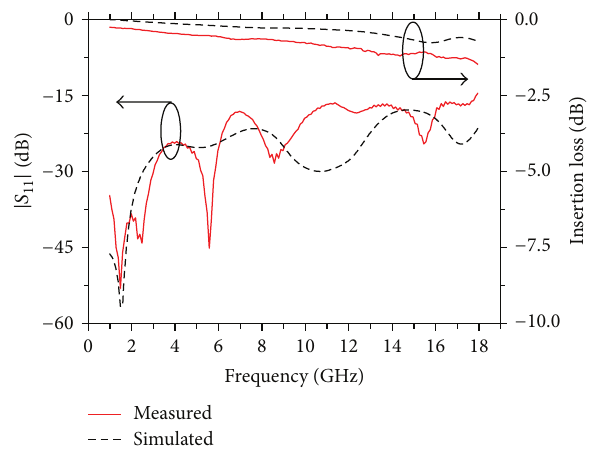
Figure 12: Reflection coefficient and insertion loss of the LTCC-based vertical transition.